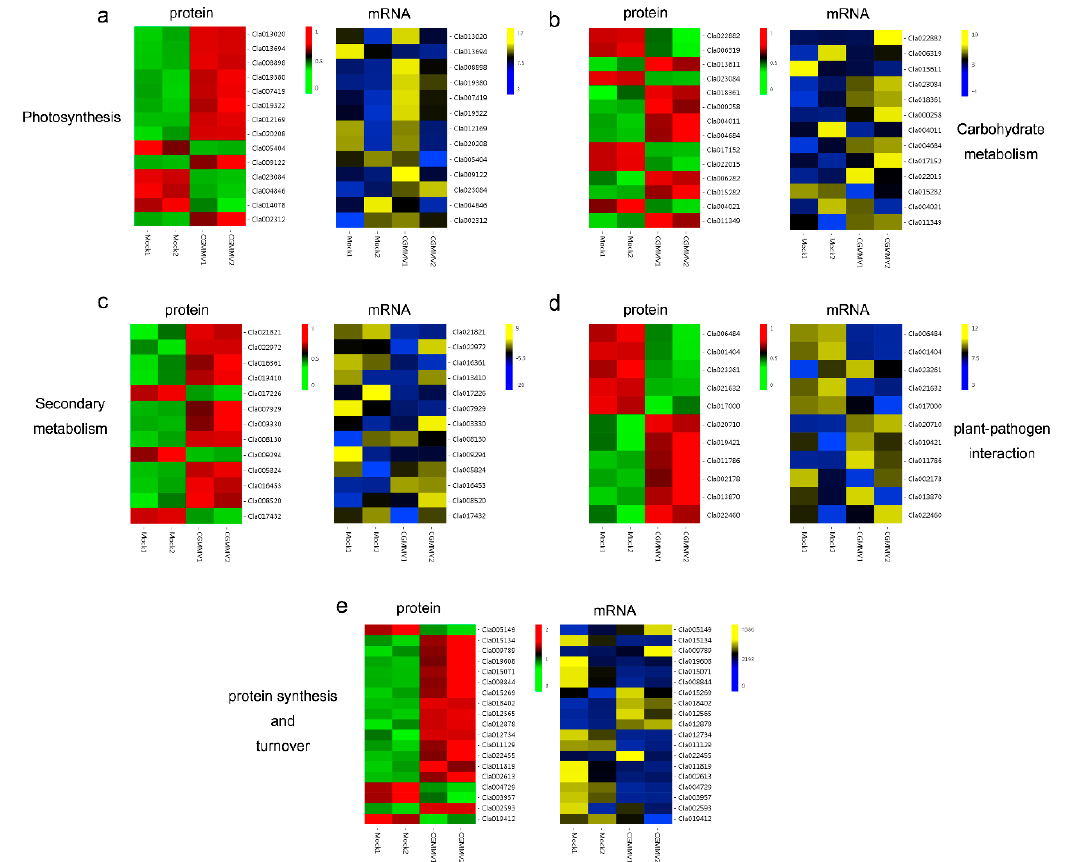
Figure 4. Correlation analysis of DAPs and their corresponding genes involved in main metabolic processes. The color (from green to red at the protein level; blue to yellow at the transcriptional level) represents protein accumulation level or gene expression level from low to high. ( a ) Photosynthesis, ( b ) carbohydrate metabolism, ( c ) secondary metabolites biosynthesis, ( d ) plant–pathogen interaction, and ( e ) protein synthesis and turnover.